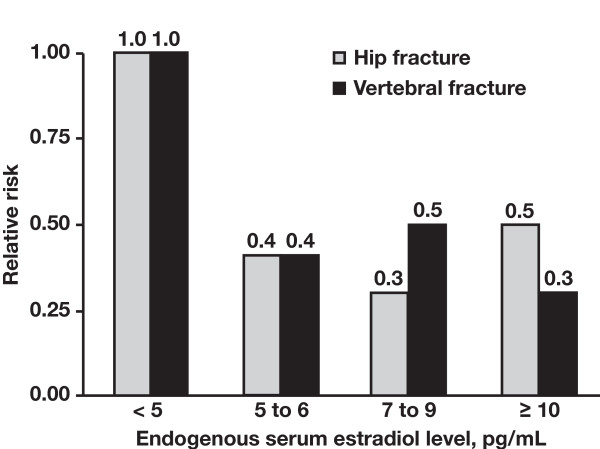
Low estrogen levels increase relative fracture risk. Reprinted with permission from Cummings SR, et al. N Engl J Med. 1998;339:733-738 [9]. Copyright © 1998, Massachusetts Medical Society. All rights reserved.